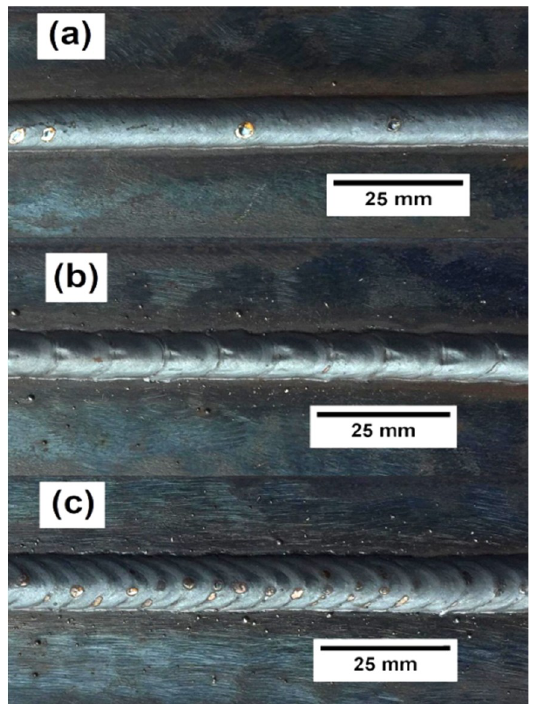
Figure 8. Superficial aspects of the beads deposited on plates (same WFS and TS) for thermographic assessment: ( a ) T1L (linear); ( b ) T1SB (switchback with F = 30 mm and B = 20 mm); ( c ) T2SB (switchback with F = 10 mm and B = 5 mm).